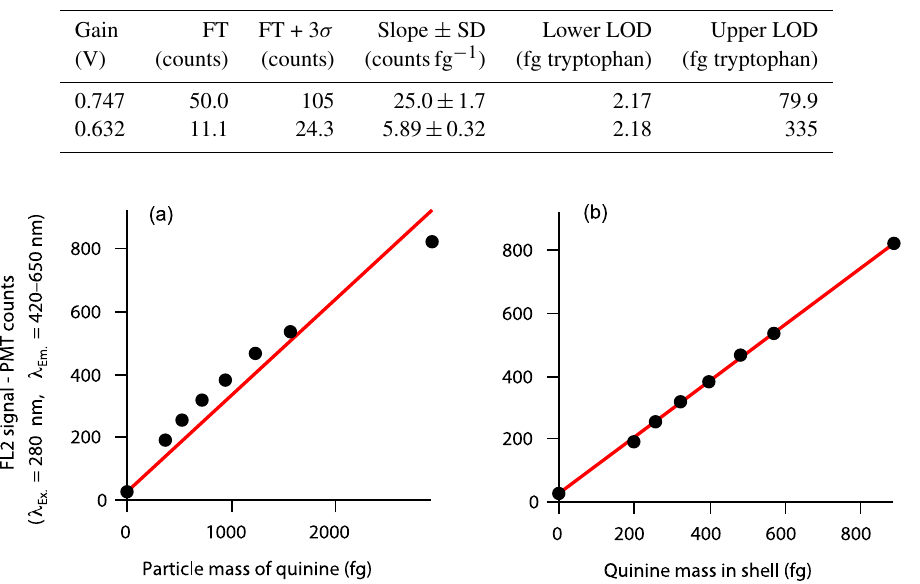
Table 2. Calibration responses and limits of detection for tryptophan for different gain voltage settings.